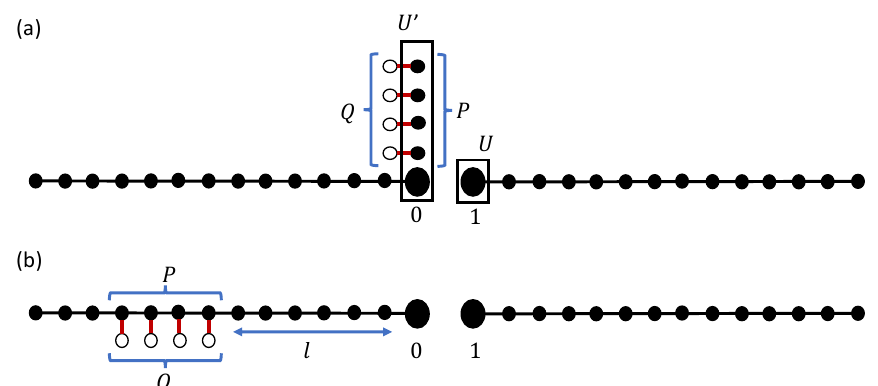
Figure 13 . Two different setups for studying information transfer between the black hole and the bath. In (a), a p -dimensional system P is added to the black hole, and in the initial state P is maximally entangled with a reference system Q . In (b), p sites of the bath at a distance l from the black hole site 0 are maximally entangled with a reference system Q in the initial state, and the dynamics are the same as in figure 9. Red lines between pairs of sites indicate that they are maximally entangled in the initial